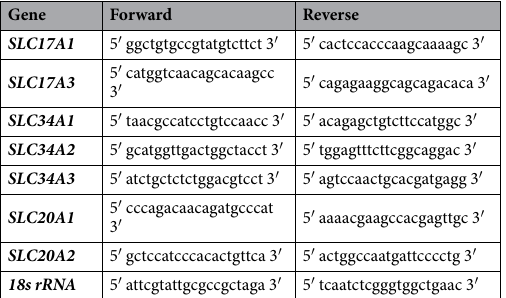
Table 1. Primer pairs used for the reverse transcription polymerase chain reaction (RT-PCR).